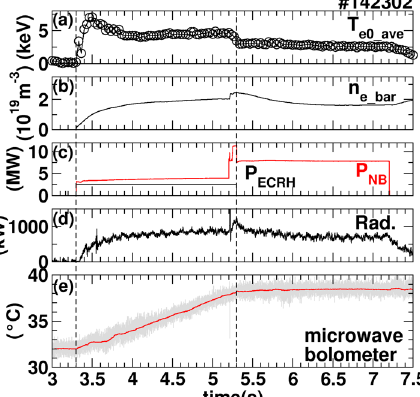
Fig.2 : Time changes of (a) averaged central electron temperature, (b) line averaged electron density, (c) total input power of ECRH and total input power of NBs, (d) radiation power from the plasma, and (e) temperature of the microwave bolometer, raw (grey) and low-pass filtered (f cutoff =40Hz, red) output of the thermocouple signal convertor.